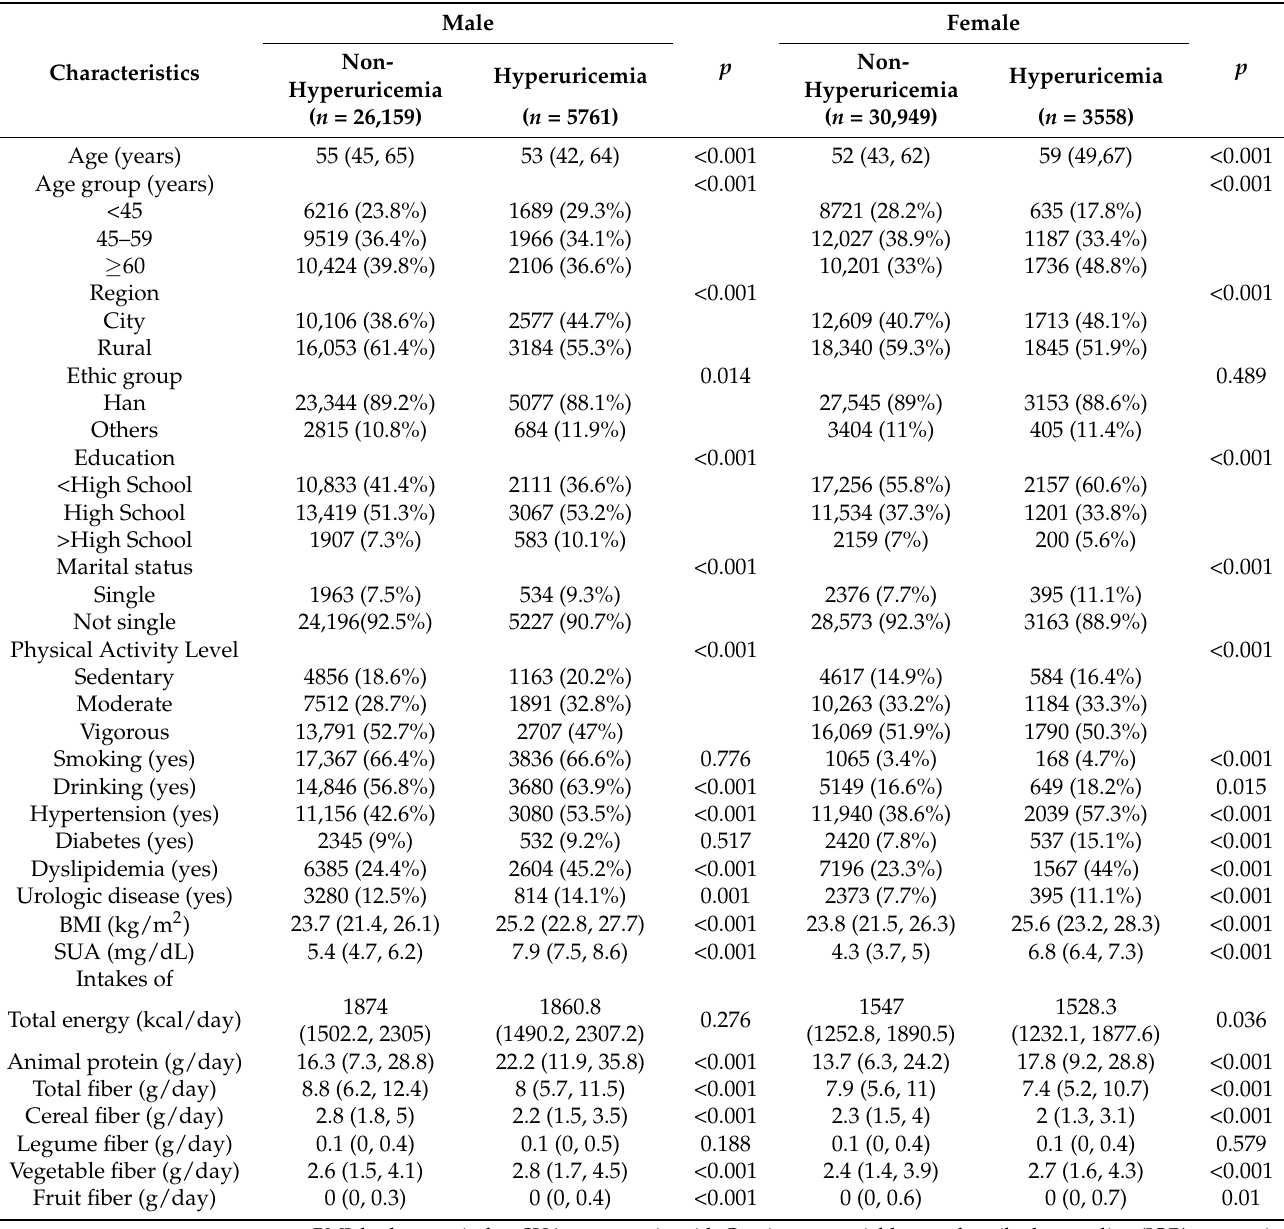
Table 1. Sample characteristics of participants with or without hyperuricemia ( n = 66,427).